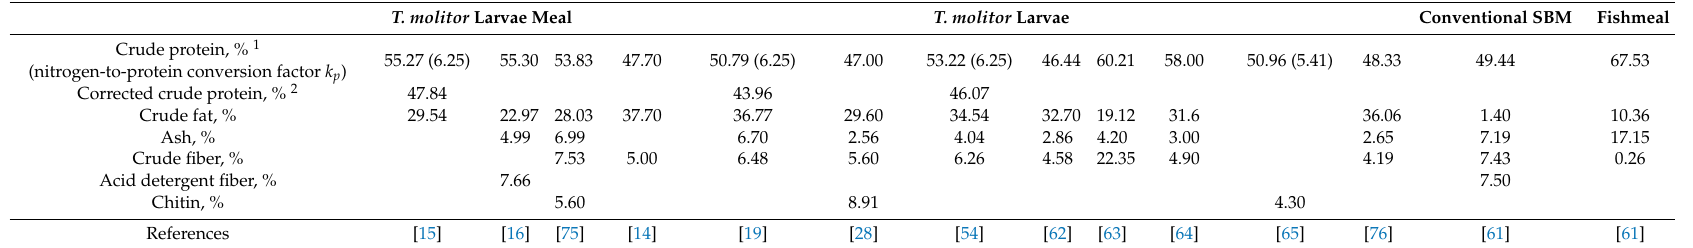
Table 1. Nutritional value of Tenebrio molitor larvae or larvae meal (DM basis).